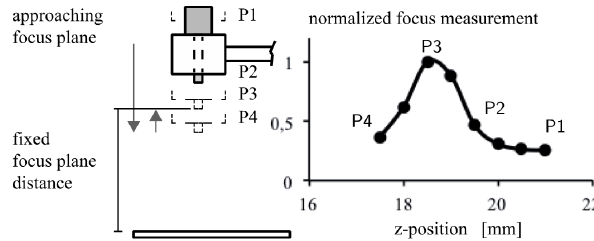
Fig. 11: The left model illustrates the proceeding of a focus measurement. On the right side 2 Figure 11. The left model illustrates the proceeding of a focus mea- normalized focus measurements are plotted against the z-coordinate of the robot. 3 surement. On the right side normalized focus measurements are Measurements start above the focus plane, so the measurement points were taken from right 4 plotted against the z coordinate of the robot. Measurements start to left. 5 above the focus plane, so the measurement points were taken from right to